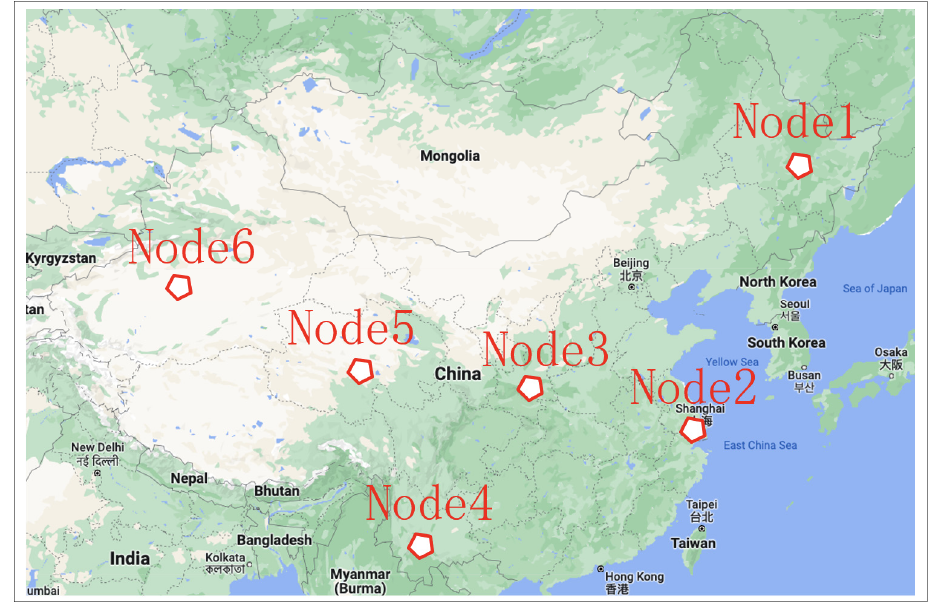
Figure 5. Ground station network topology. Table 2. Link status in 24